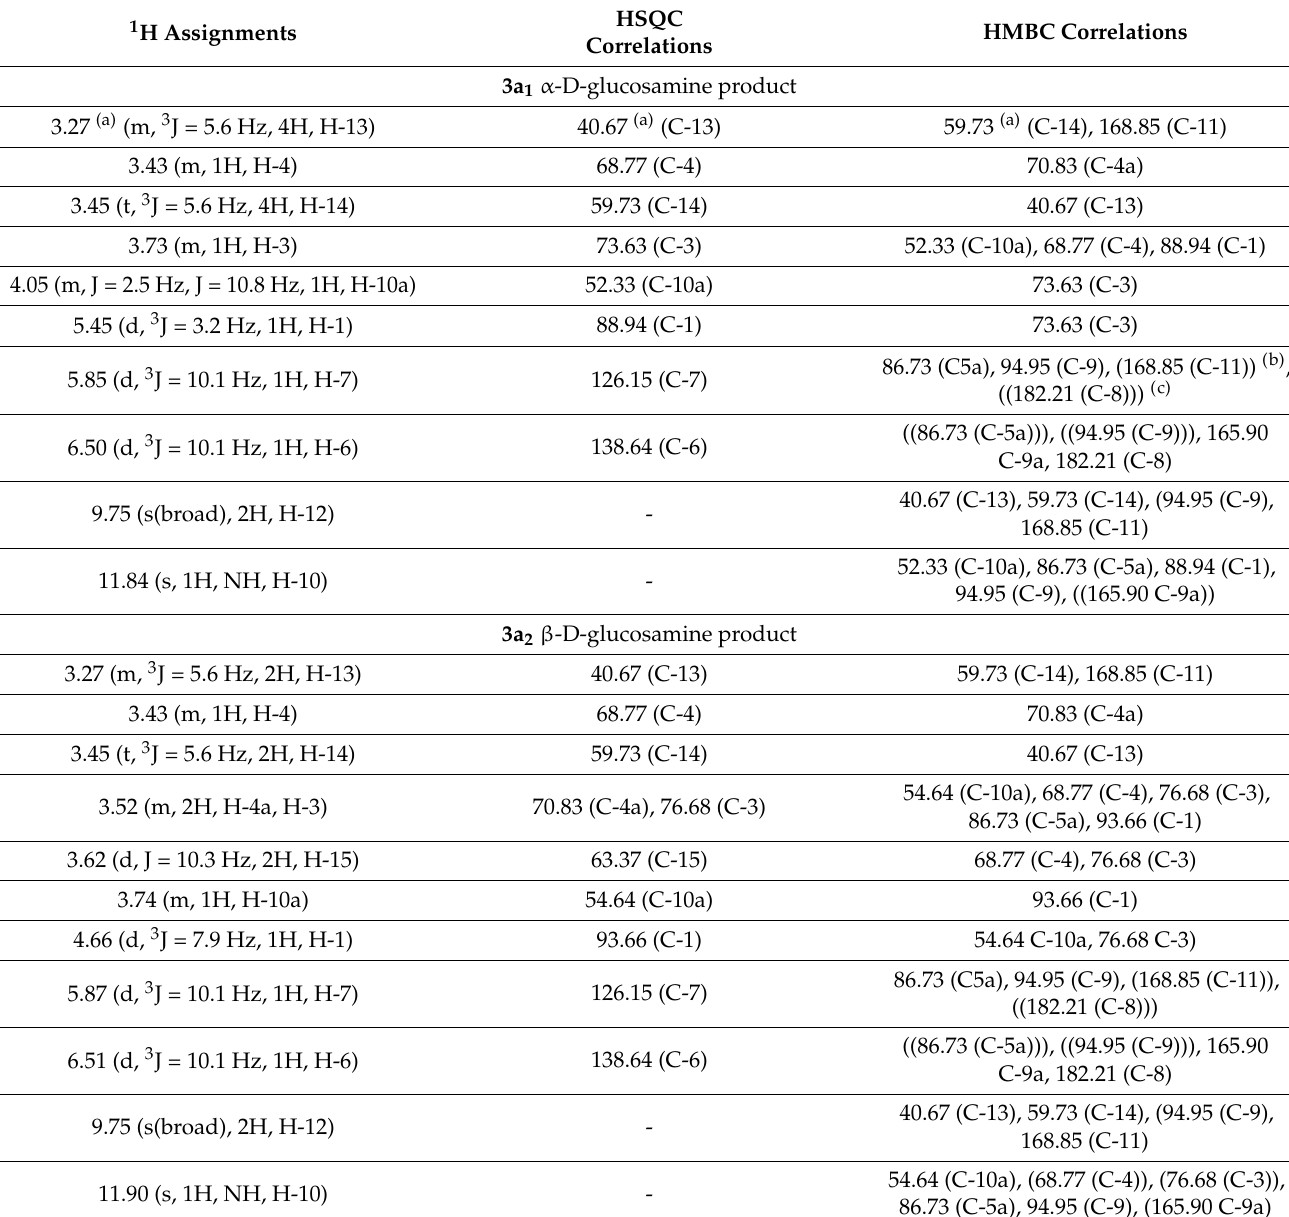
Table 2. 1 H assignments, and HSQC and HMBC correlations for 3a